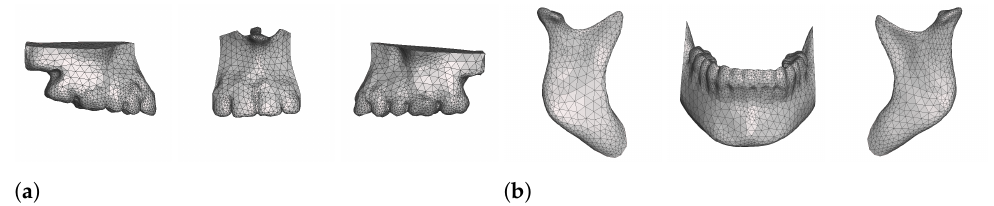
Figure 5. Meshes of bones after cleanup, cut and refinement in Meshmixer. Image ( a ) shows three maxillary segments; image ( b ) shows three mandibular